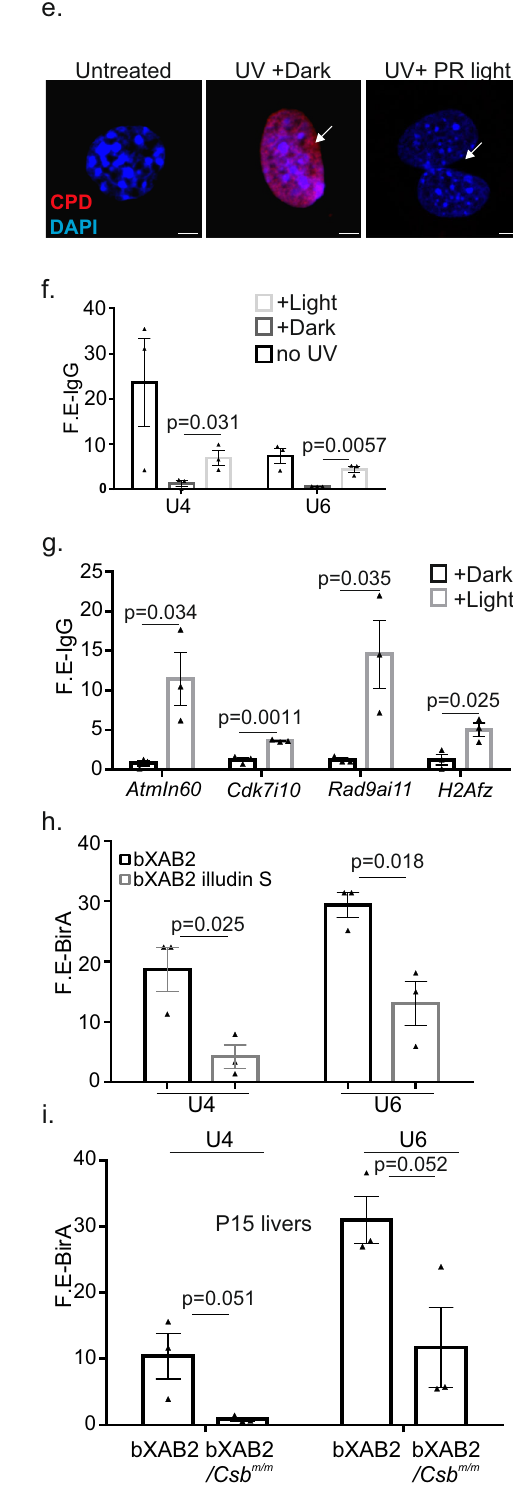
nascent transcripts 74 – 77 and that ATM (and likely ATR) function downstream of the spliceosome displacement 11 . Nascent pre-mRNAs that associate with transcription com- plexes blocked at DNA lesions are released from late-spliceosome components and hybridize to the template strand of the melted DNA to form RNA:DNA duplexes (R-loops), a structure that slows transcription and activates DDR 77 . Increased formation of